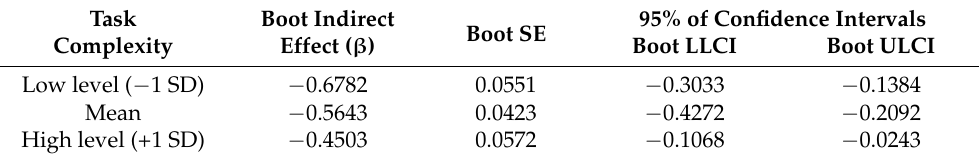
Table 8. Moderated mediation results for a conditional indirect effect.